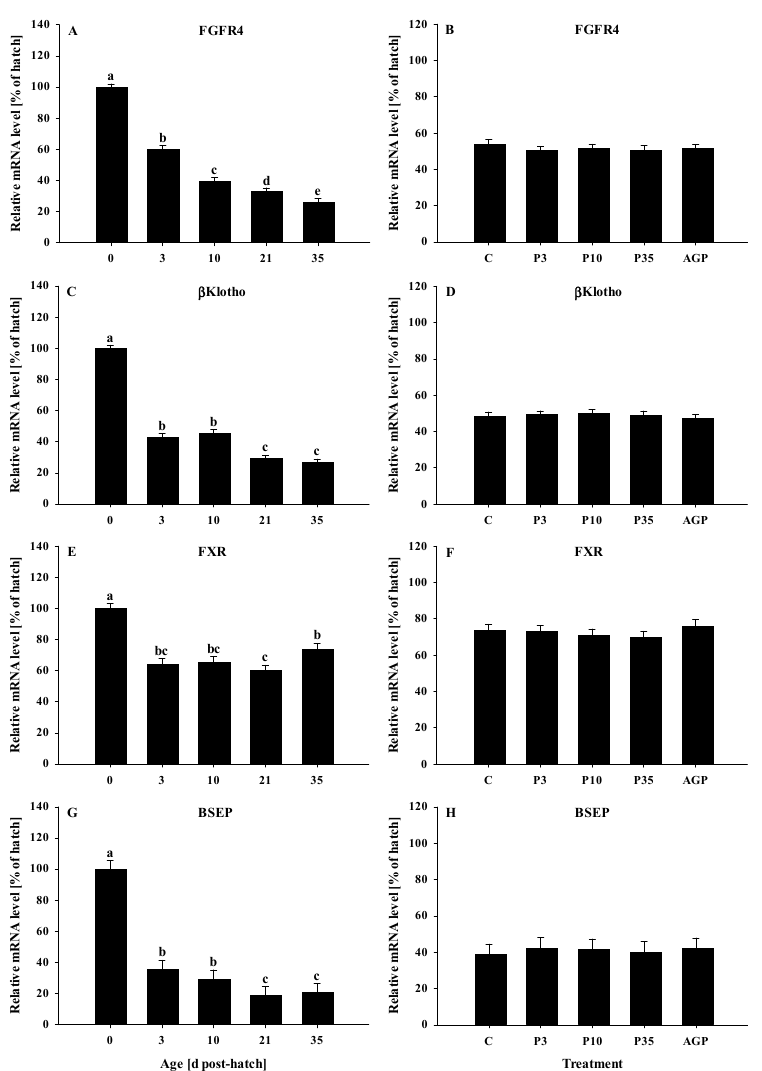
Figure 4. Age and treatment effects on mRNA levels of genes associated with bile acid metabolism in the liver. Age effects on ( A ) fibroblast growth factor receptor 4 (FGFR4), ( C ) beta klotho ( β klotho), ( E ) farnesoid X receptor (FXR), and ( G ) bile salt exporter pump (BSEP). Treatment effects on ( B ) FGFR4, ( D ) β klotho, ( F ) FXR, and ( H ) BSEP. The expression level of hatch (day 0) was set to 100%, and other values were calculated as a % of the hatch data. Each value represents mean ± SE. Treatments are C, normal water (without supplements) from day 0 to 35 post-hatch; P3, FM in water for first 3 days post-hatch, followed by normal water until day 35; P10, FM in water for first 10 days post-hatch, followed by normal water until day 35; P35, FM in water from hatch to day 35; and AGP, AGP in water from hatch to day 35. a,b,c,d,e Letters indicate significance ( p < 0.05) between days